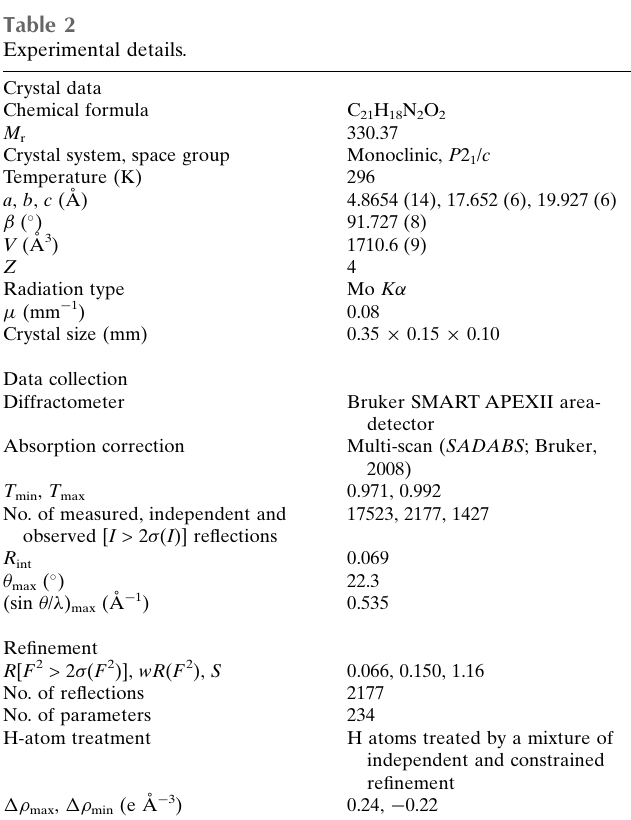
Table 2 Experimental details.